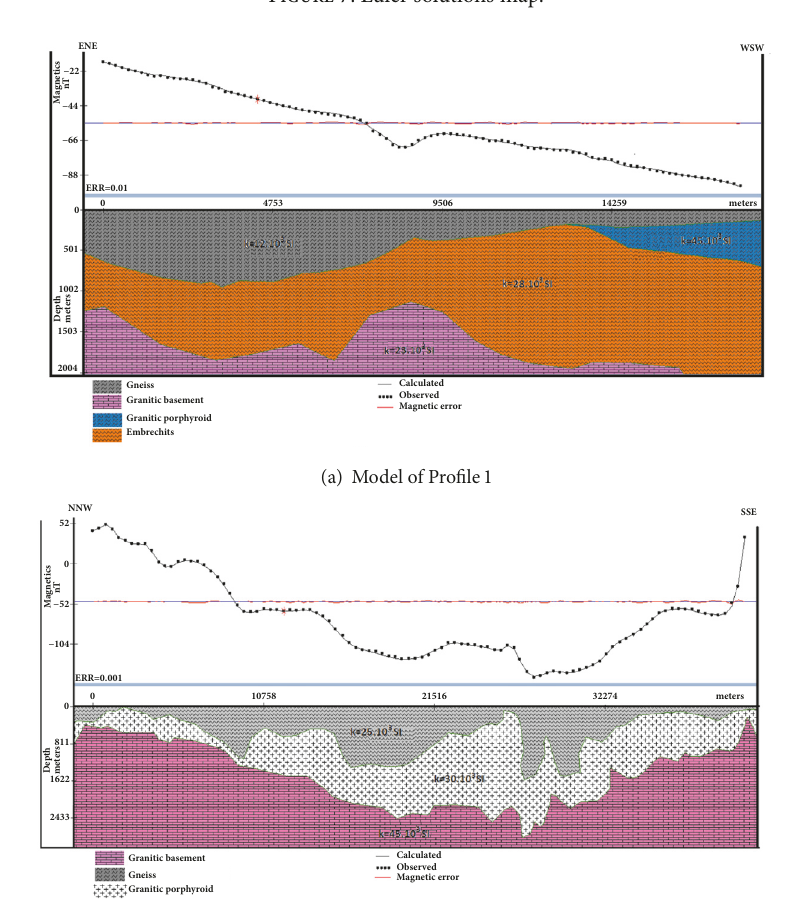
(b) Model of Profile